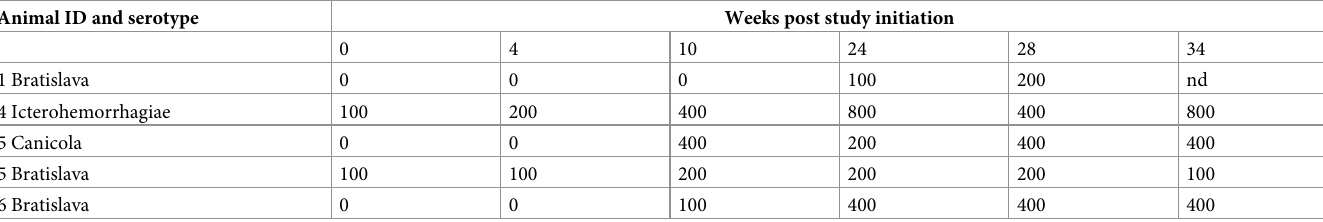
Serum samples were collected from 17 pigs at 5 to 6 months of age, prior to their first Leptos- pira vaccination, and MAT testing was performed. The day 0 timepoint had no pigs with a titer greater than 1:100 (Table 1). While a few pigs in the unvaccinated group did have low level titers to some serovars, at no time in the study did any unvaccinated animal have a titer greater than 1:800 for any serovar (Table 2). In contrast to the results of the unvaccinated ani- mals, 9 out of 9 vaccinated pigs were positive for serovars Icterohaemorrhagiae and Bratislava some time point (Table 3 and Fig 1A). However, for the other serovars the majority of Table 2. MAT titers in unvaccinated pigs, only serotypes that had a positive result are included. Animal ID and